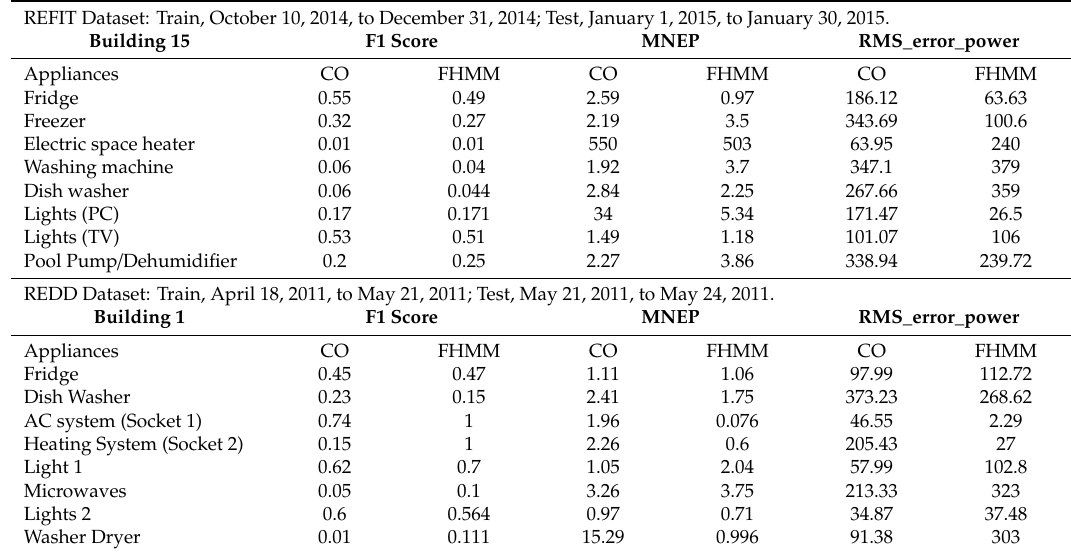
Table 4. Accuracy metrics for both datasets using F1 score, root mean square (RMS) error power and mean normalized error power (NEP)